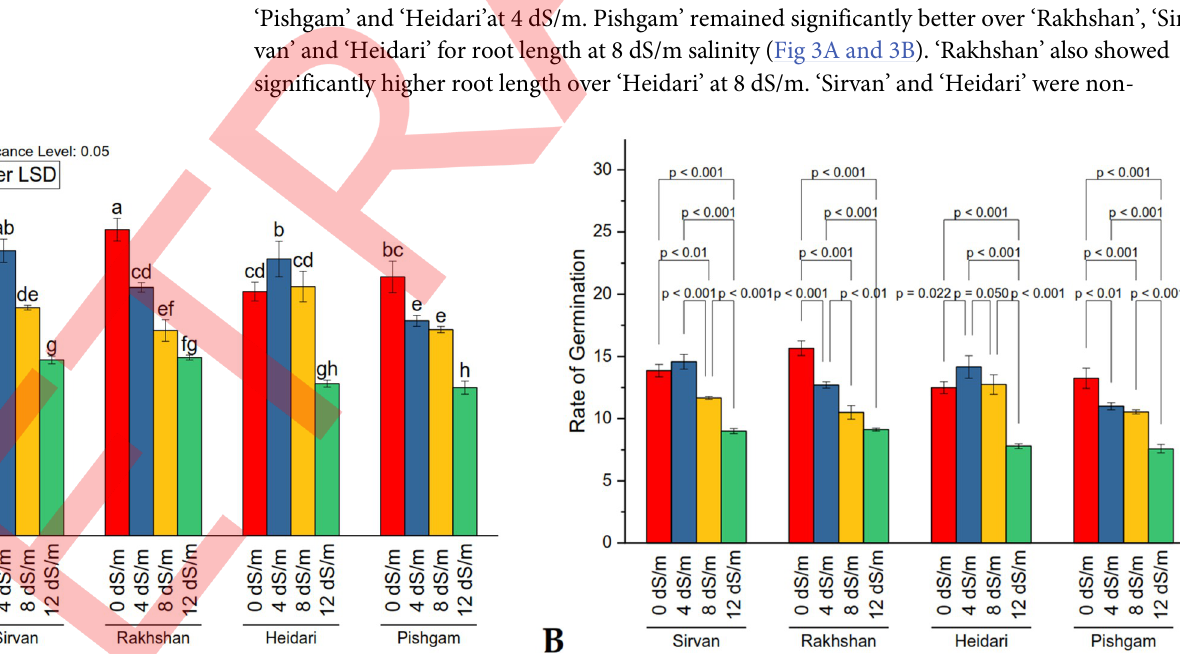
PLOS ONE | https://doi.org/10.1371/journal.pone.0258703 November4,